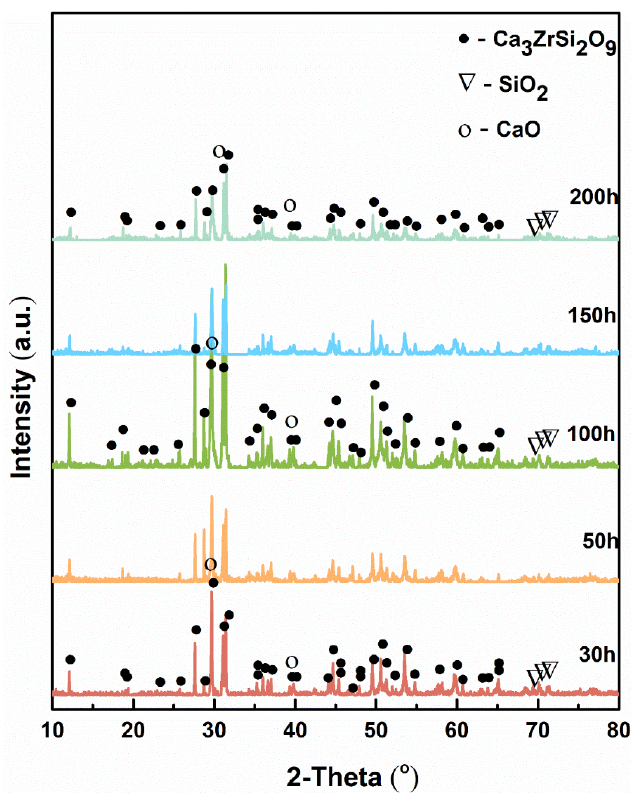
Figure 6. XRD patterns of the CZSO coating aged at 1100 °C for 30–200 h.